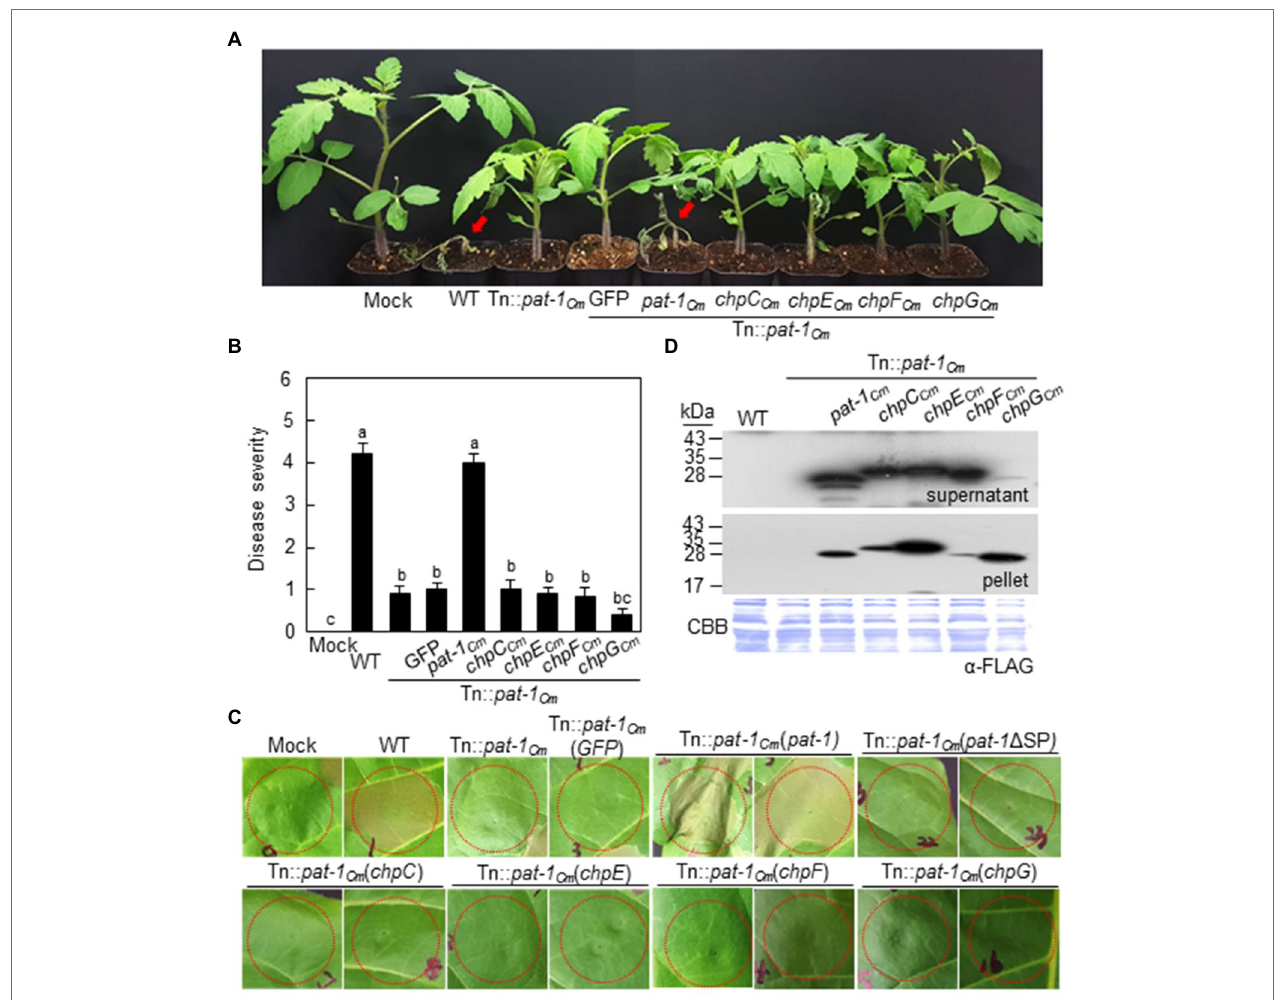
FIGURE 5 | No recovery of either pathogenicity or HR-eliciting activity of Clavibacter michiganensis mutant Tn:: pat-1 Cm by chromosomal homologs of pat-1 Cm ( chp ) genes. (A) Wilting symptom development after inoculation with Tn:: pat-1 Cm carrying chpC Cm , chpE Cm , chpF Cm , or chpG Cm . Inoculated plants were observed for 2 weeks and photographed 14 dai. (B) Disease severity of wilting in tomato plants inoculated with the indicated strains at 14 dai. Error bars indicate SE ( n = 10). Nonparametric Kruskal–Wallis test with Dunnett’s multiple comparisons ( p < 0.05) was used to analyze the level of disease severity in tomato plants, and different letters indicate statistically significant differences at p < 0.05. (C) HR phenotype in Nicotiana tabacum after infiltration with the indicated strains. Leaves of 5-week-old plants were inoculated, and representative leaves were photographed at 36 h after infiltration. Red dotted lines indicate the infiltrated regions. (D) Expression and secretion of Pat-1 Cm and Chp proteins in complemented strains. All proteins were fused to FLAG on their C-termini and expressed in Tn:: pat-1 Cm . Total proteins from the supernatant and pellet were analyzed by immunoblot using anti-FLAG antibody. CBB, Coomassie Brilliant Blue. Mock, 10 mM MgCl 2 ; WT, C. michiganensis LMG7333 wild